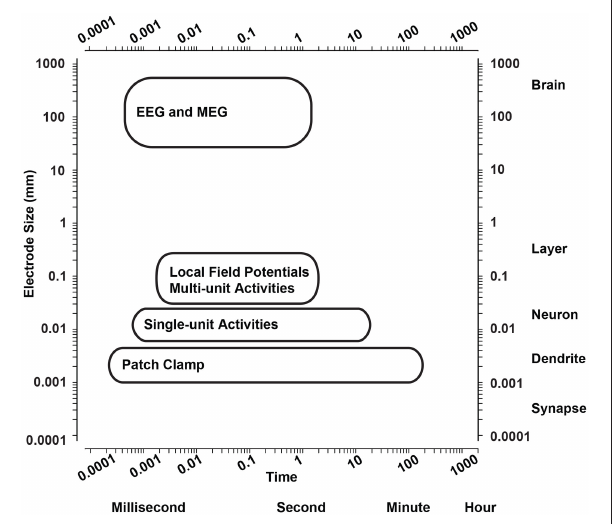
FIGURE 1 | Spatiotemporal range of neurophysiological signal acquisition techniques. Spatiotemporal range of the main techniques to measure neurophysiological signals from the brain. EEG, electroencephalography; MEG,